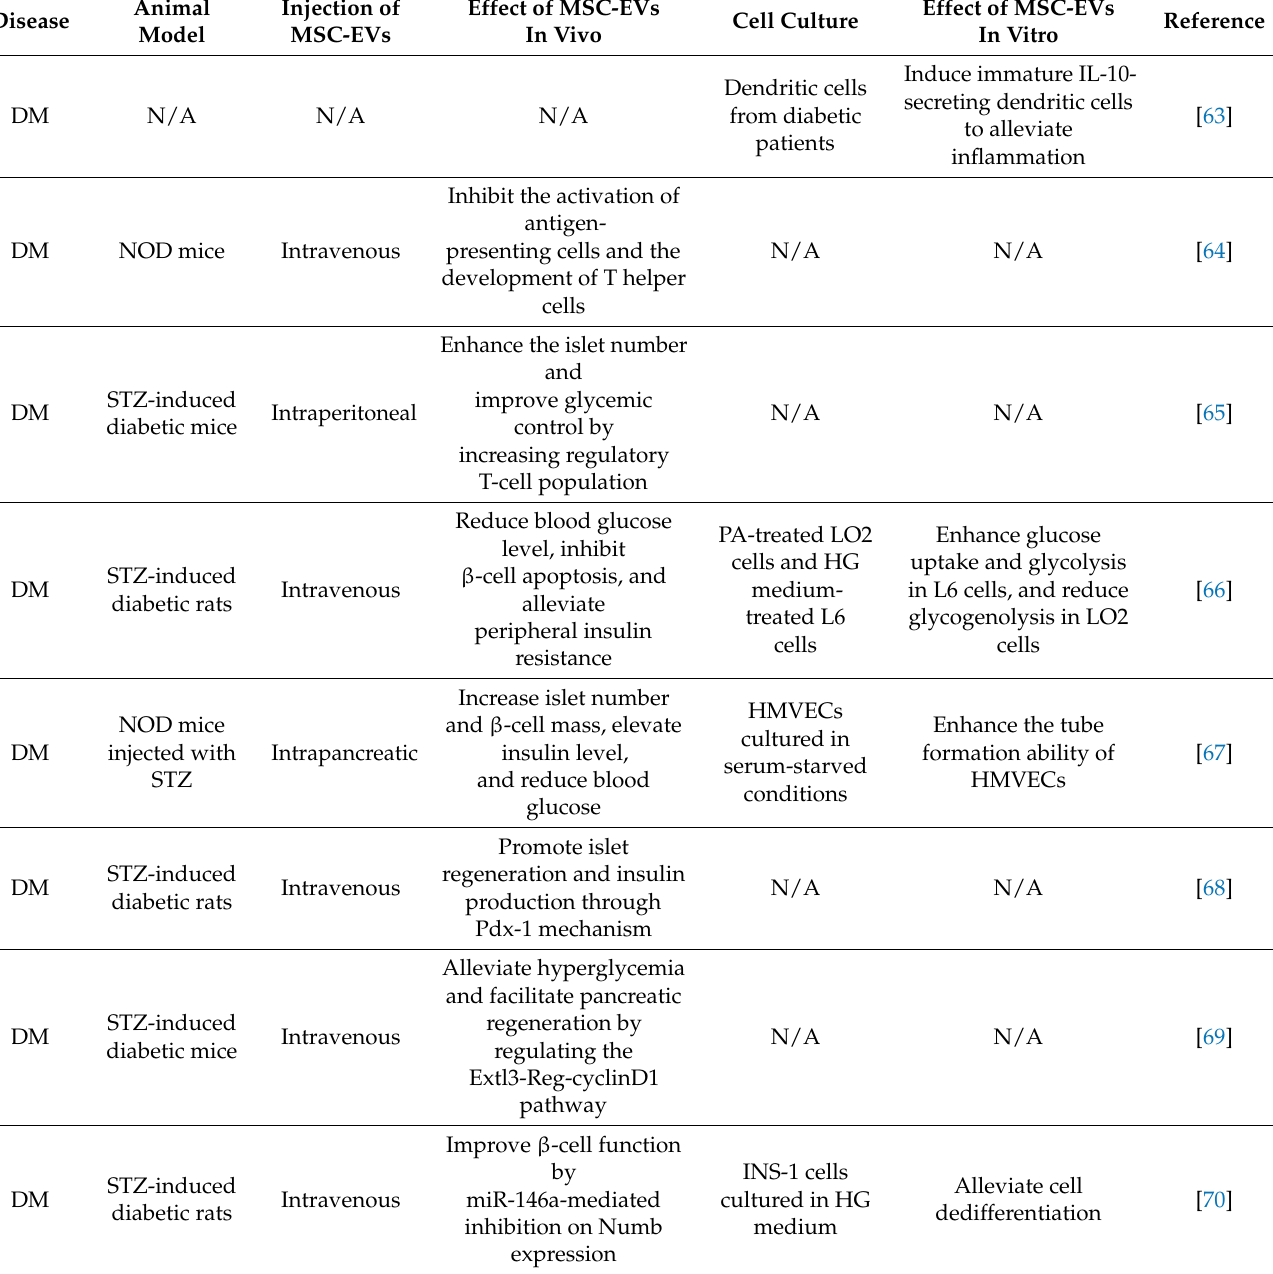
Table 2. Therapeutic function of natural MSC-EVs in DM and diabetic